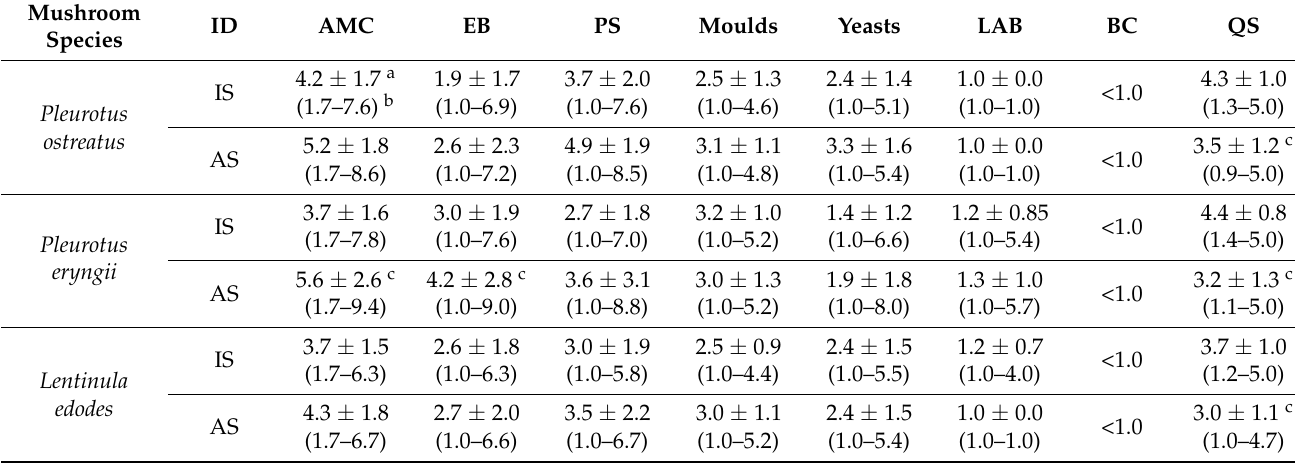
Table 2. Average microbial counts and sensory quality scores of cultivated mushroom species on the day of purchase (initial) and after